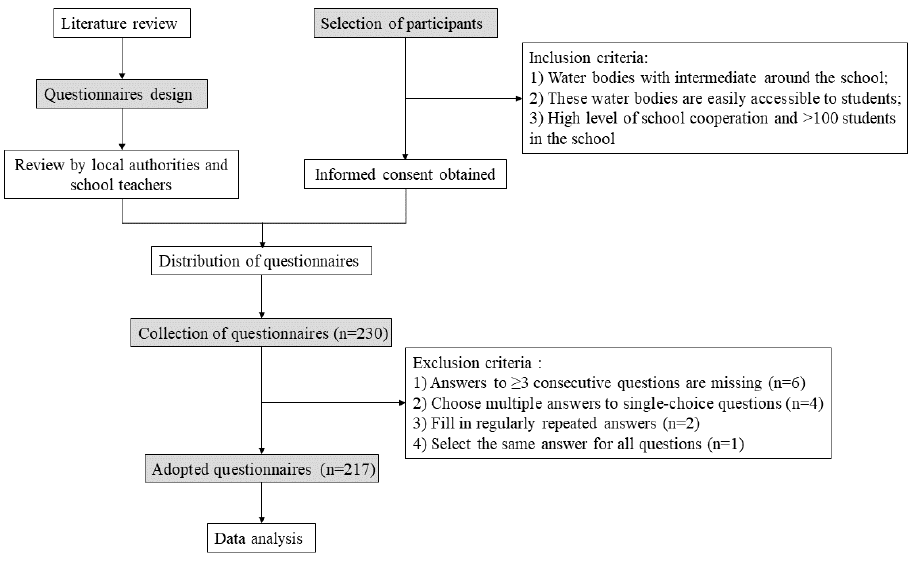
Figure 1. Flowchart of the